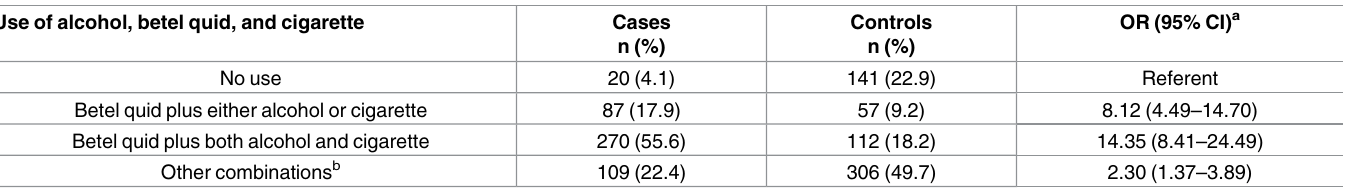
We observedthat the risk of HNC was higher among individuals who consumed cigarette and alcohol in addition to BQ (Table 4). Compared to no use of alcohol, BQ, and cigarette, use of BQ plus either alcohol or cigarette had an OR = 8.12 (95% CI: 4.49–14.70), while use of alco- hol, BQ, and cigarette had an OR = 14.35 (95% CI: 8.41–24.49). Finally, we analyzed the association between BQ chewing and age of HNC diagnosis. BQ users were significantly younger in the mean age of HNC diagnosis than non-BQ users (mean age: 53.35 years vs. 58.62 years, P < 0.0001). After adjusting for education, alcohol, and ciga- rette, BQ users still had a younger mean age of diagnosis than non-BQ users by 5.78 years ( P < 0.0001). HNC patients who were regular alcohol drinkers (at least once a week) were on average 2.22 years younger in age of HNC diagnosis compared to those who were occasional/ non-drinkers ( P = 0.02). Smoking was not associated with the age of HNC diagnosis ( P = 0.98). Patients with oral cancer (mean age = 53.59 years) and pharyngeal cancer (mean age = 53.90 years) were significantly younger than laryngeal cancer patients (mean age = 62.99 years) ( P < 0.0001). HNC patients who used BQ, alcohol, and cigarette had a significantly younger Table 4. The association between the use of alcohol, betel quid, and cigarette and risk of head and neck cancer. Use of alcohol, betel quid, and cigarette Cases n (%) Betel quid plus either alcohol or cigarette Betel quid plus both alcohol and cigarette Other combinations b Abbreviations: CI = confidence interval; OR = odds ratio a OR and 95% CI were calculated using unconditional logistic regression, adjusted for age and education. b Other combinations included other combinations of alcohol, betel quid, and cigarette, including alcohol only, betel quid only, cigarette only, and alcohol +